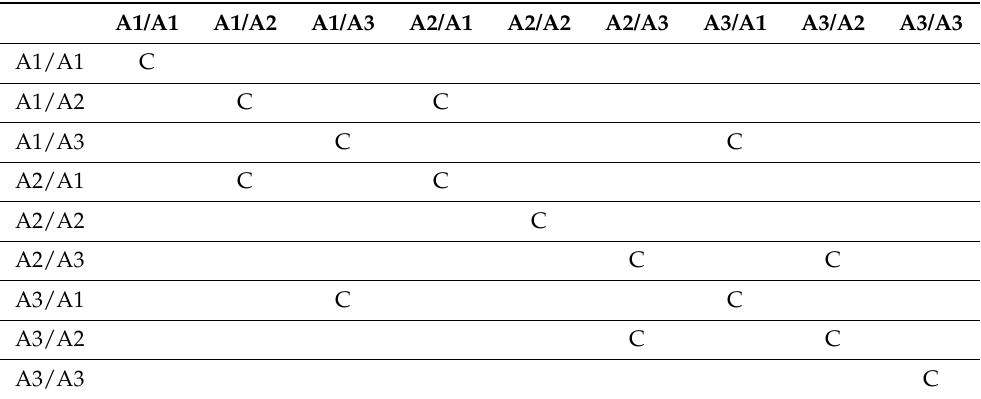
Table 2. Compatibility between 18.5% of randomly selected heterokaryons variable at a single triallelic locus. Squares with the letter C indicate compatible